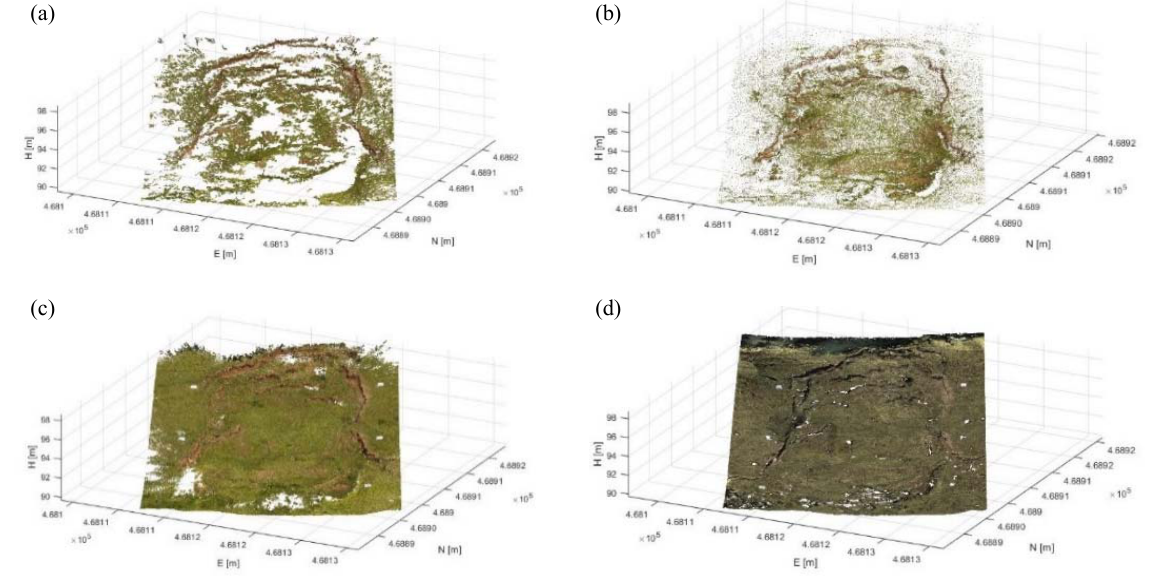
Figure 5. Photogrammetric point clouds obtained from the three adopted SfM approaches; (a) VisualSFM, (b) Autodesk 123D Catch, (c) Agisoft PhotoScan and (d) the TLS validation